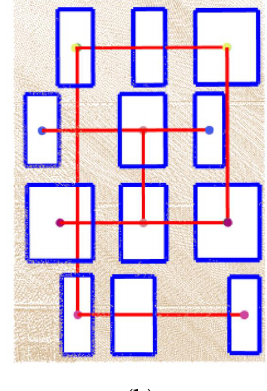
Figure 13. A comparison of the grid assumption approach and the flexible inference approach. ( a ) Opening detection by a sliding window method, where the black lines are the border lines. The blue dots are the corners of openings. ( b ) Opening detection and reconstruction by our approach. The blue frames represent the reconstructed openings. Red lines with endpoints in specific colors represent the spatial relationship of the